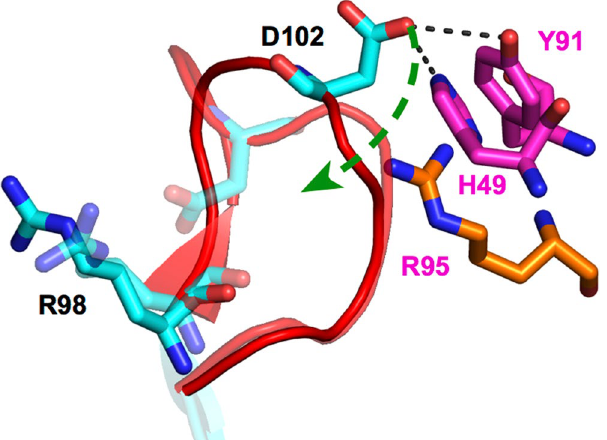
Figure 6. Predicted pathway for cis-trans isomerisation in the CDR-H3 loop. Arg95 in the VL is coloured in orange. Asp102 interacting with Tyr91 and His49 in the VL then interacts with Arg95, and rotates to bind to Arg98 in the VH. The structure of the trans-complex is also shown as transparent sticks and a cartoon. Residues are represented using the one-letter code for amino